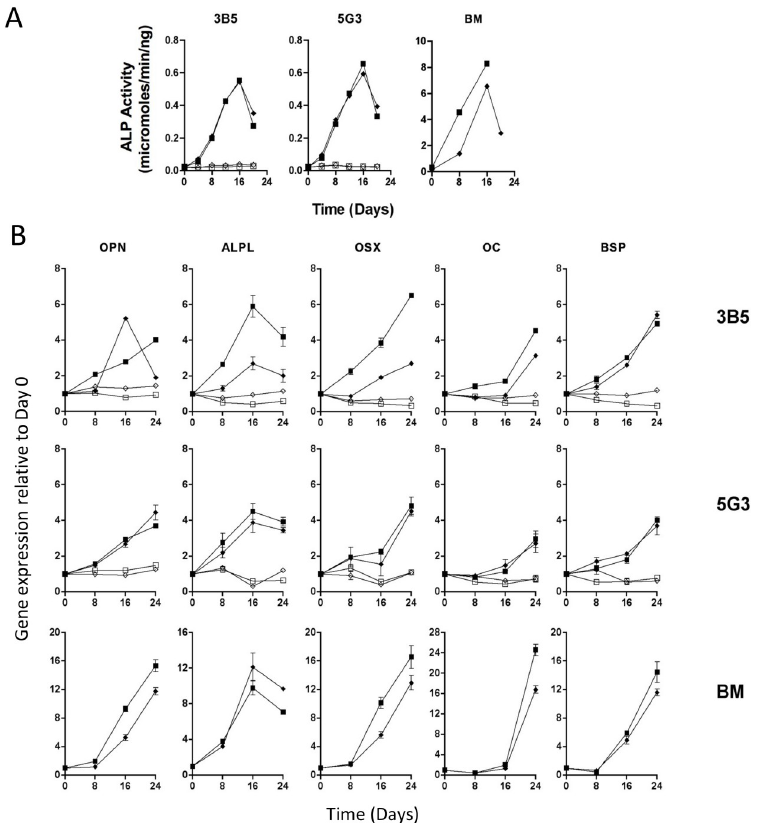
Fig 4. Stromal cells reflect osteogenic progenitors. The 5G3 and 3B5 stromal cell lines were cultured under osteogenic conditions (closed symbols), and under normal growth conditions as a control (open symbols). Duplicate experiments are shown by different symbols, and data points represent mean ˚ SE of three experimental replicates. Comparison was made with bone marrow-derived mesenchymal cells cultured in parallel under osteogenic